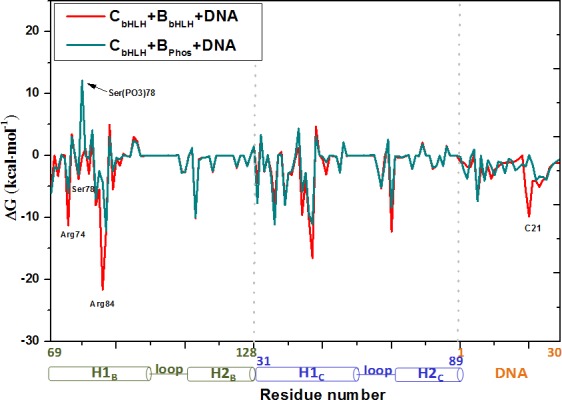
Energy decompositions of the CbHLH+BbHLH+DNA and CbHLH+BPhos+DNA models.MM-PBSA energy decompositions (kcal·mol-1) into the residues of the bHLH domains and the bases of the DNA molecule for the CbHLH+BbHLH+DNA (red) and CbHLH+BPhos+DNA (sky blue) models.